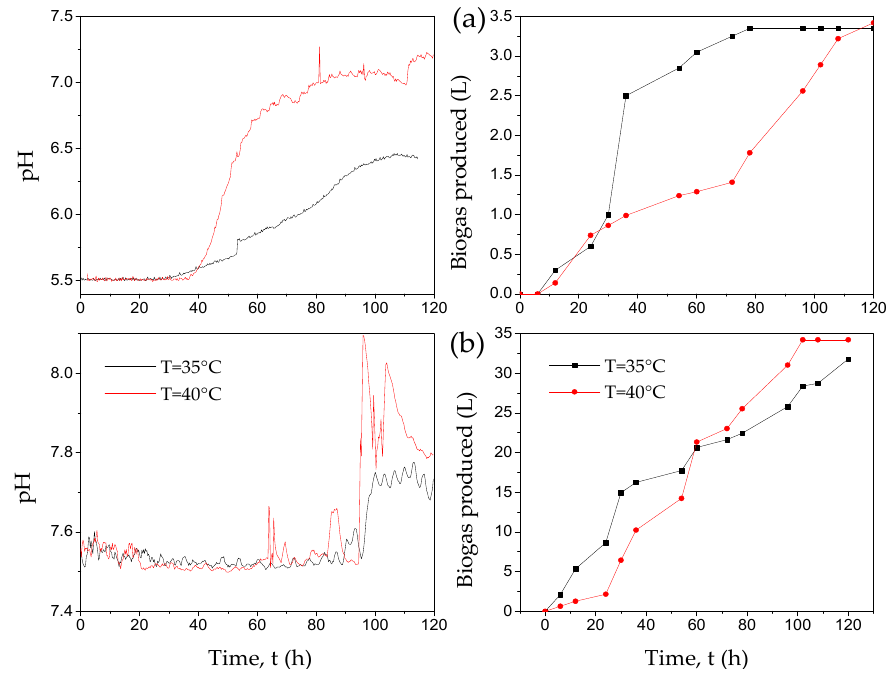
Figure 2. Dynamic profiles of pH and biogas production, ( a ) pH = 5.5 and ( b ) pH = 7.5.